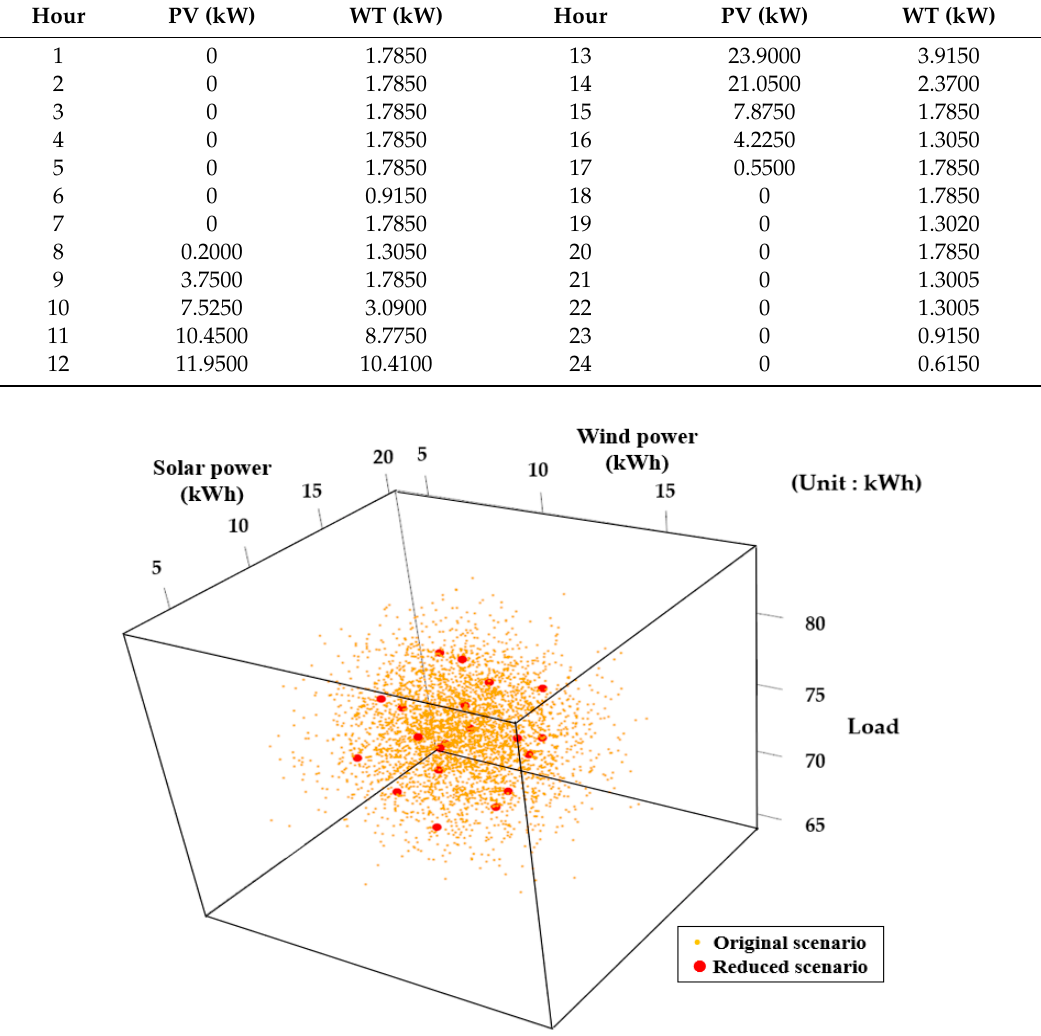
Figure 6. Scenario generation and reduction results.